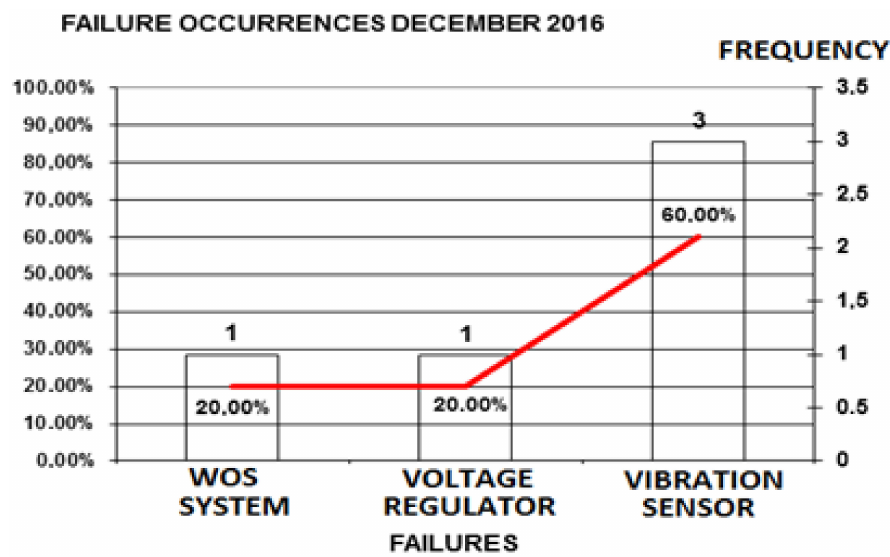
Figure 12. Failure occurrences, December 2016.